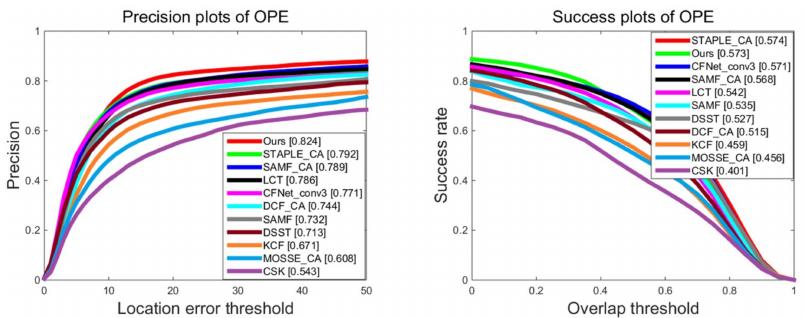
Figure 4. The tracking results of the proposed algorithm with comparisons to 10 state-of-the-arts CF based trackers on OTB-100 benchmark